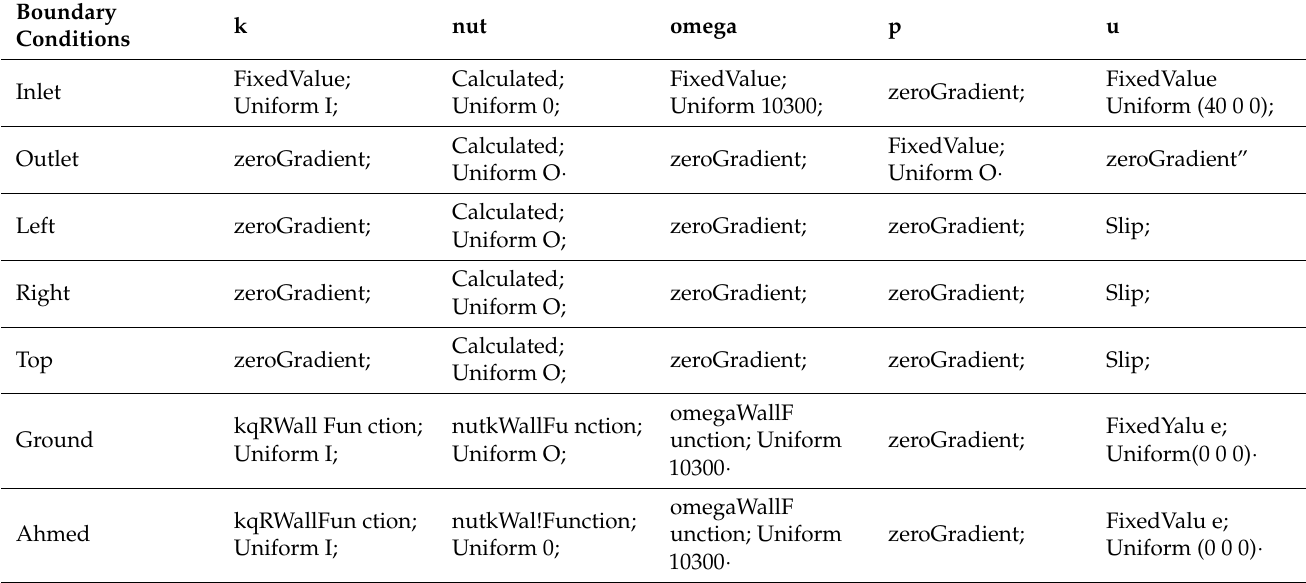
Table 1. Boundary conditions.